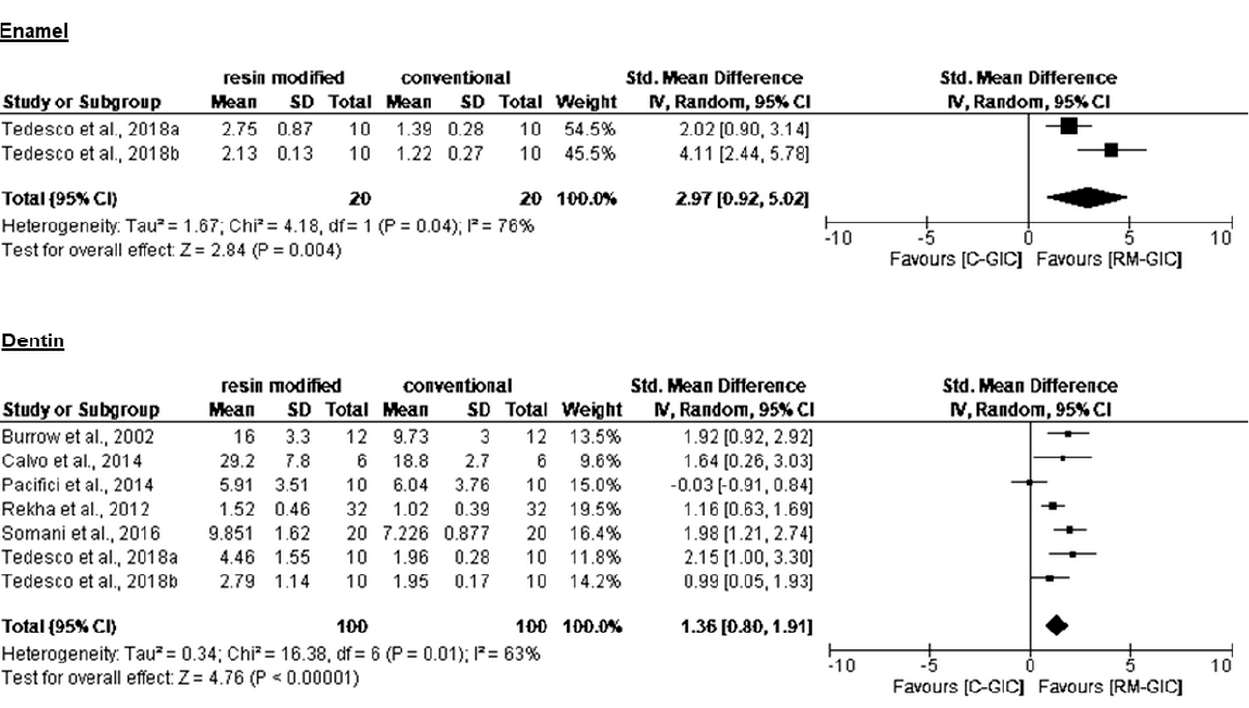
Figure 2. Forest plot for the meta-analysis of C-GIC and RM-GIC immediate bond strength in primary enamel and dentin.